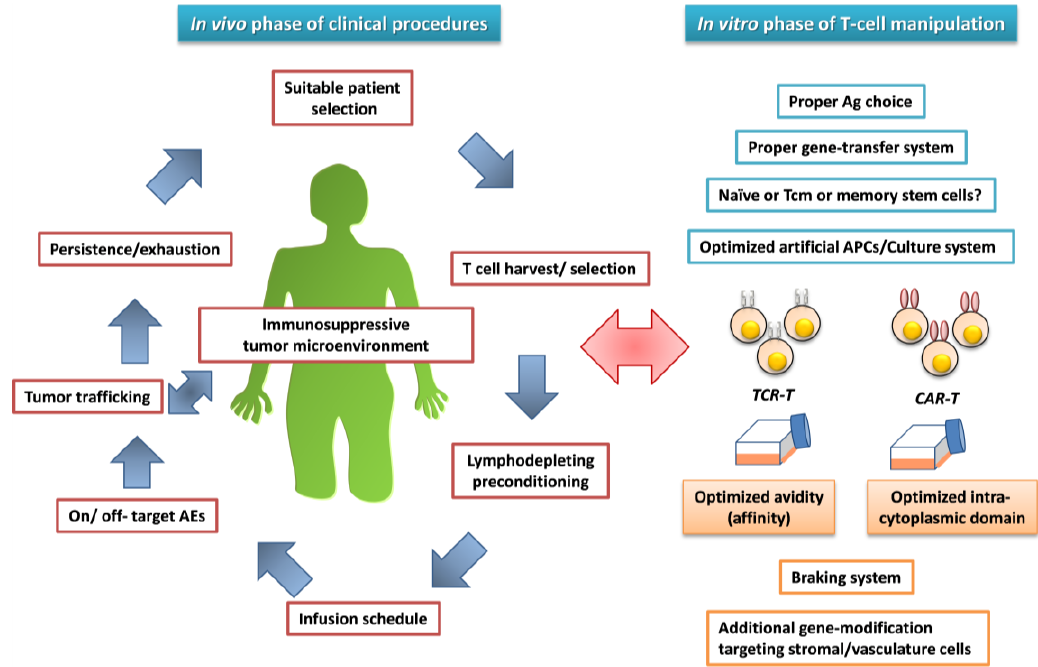
Figure 3. Unsolved issues for the establishment of successful antileukemia adoptive immunotherapy using gene-modified T